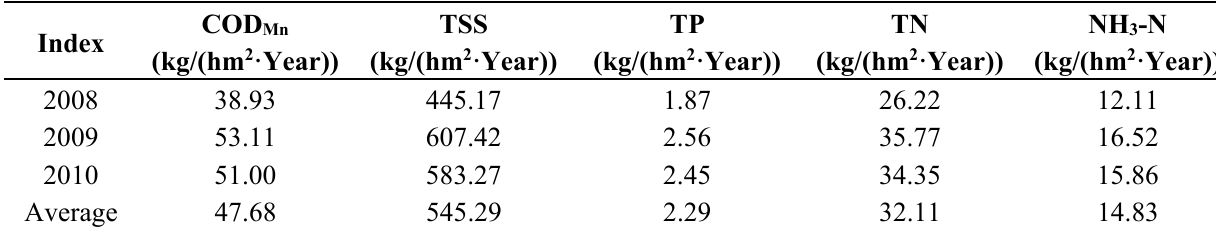
Table 5. The annual NPS pollution loads from 2008 to